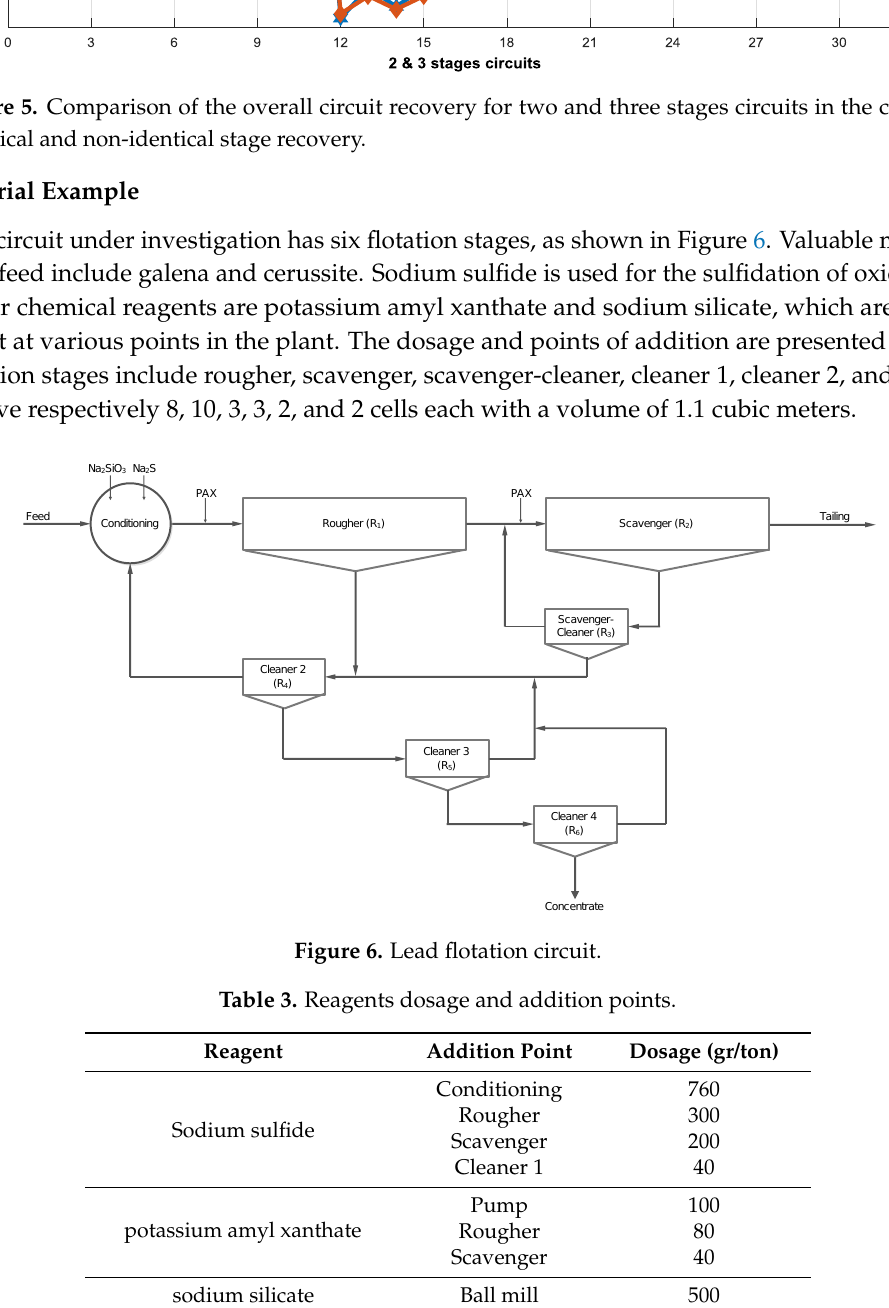
identical and non-identical stage recovery.